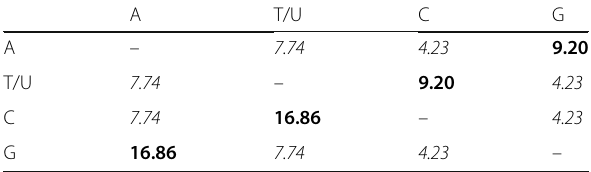
Table 2 Maximum likelihood estimate of substitution matrix